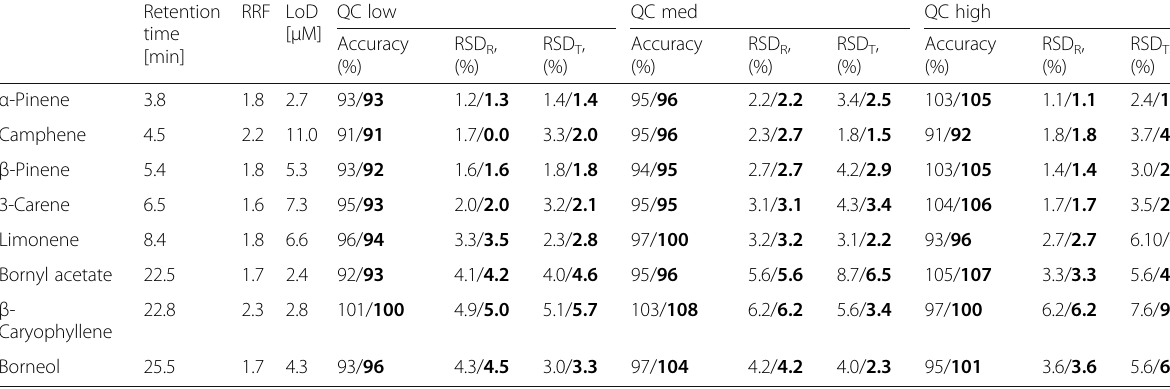
Data calculated with the RRF are in bold